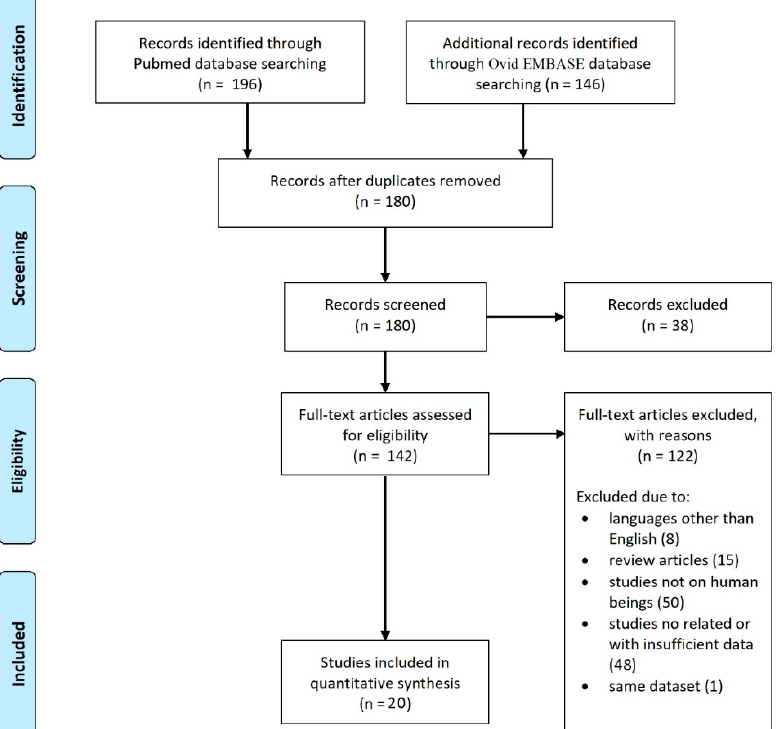
Figure 1. PRISMA flow diagram.